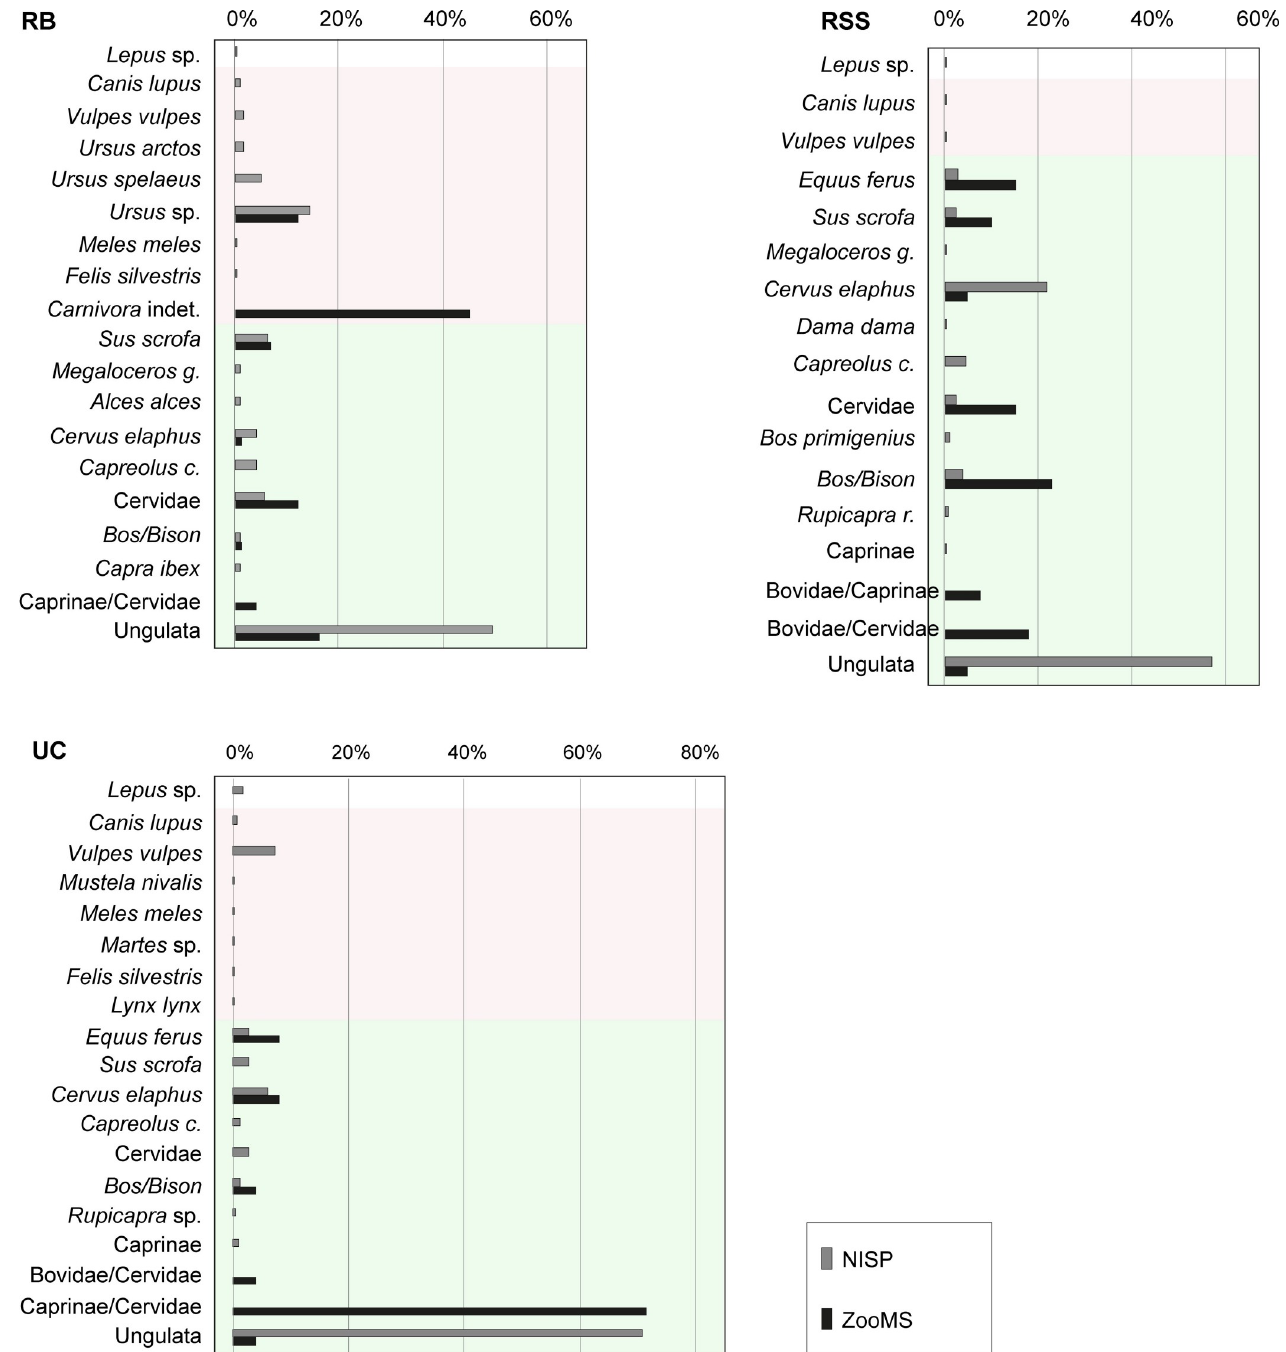
Fig 3. Taxonomic results from zooarchaeological identification and ZooMS. Comparison between the taxonomic determinations obtained through zooarchaeological analysis and ZooMS for the sites analysed (RB, UC and RSS).